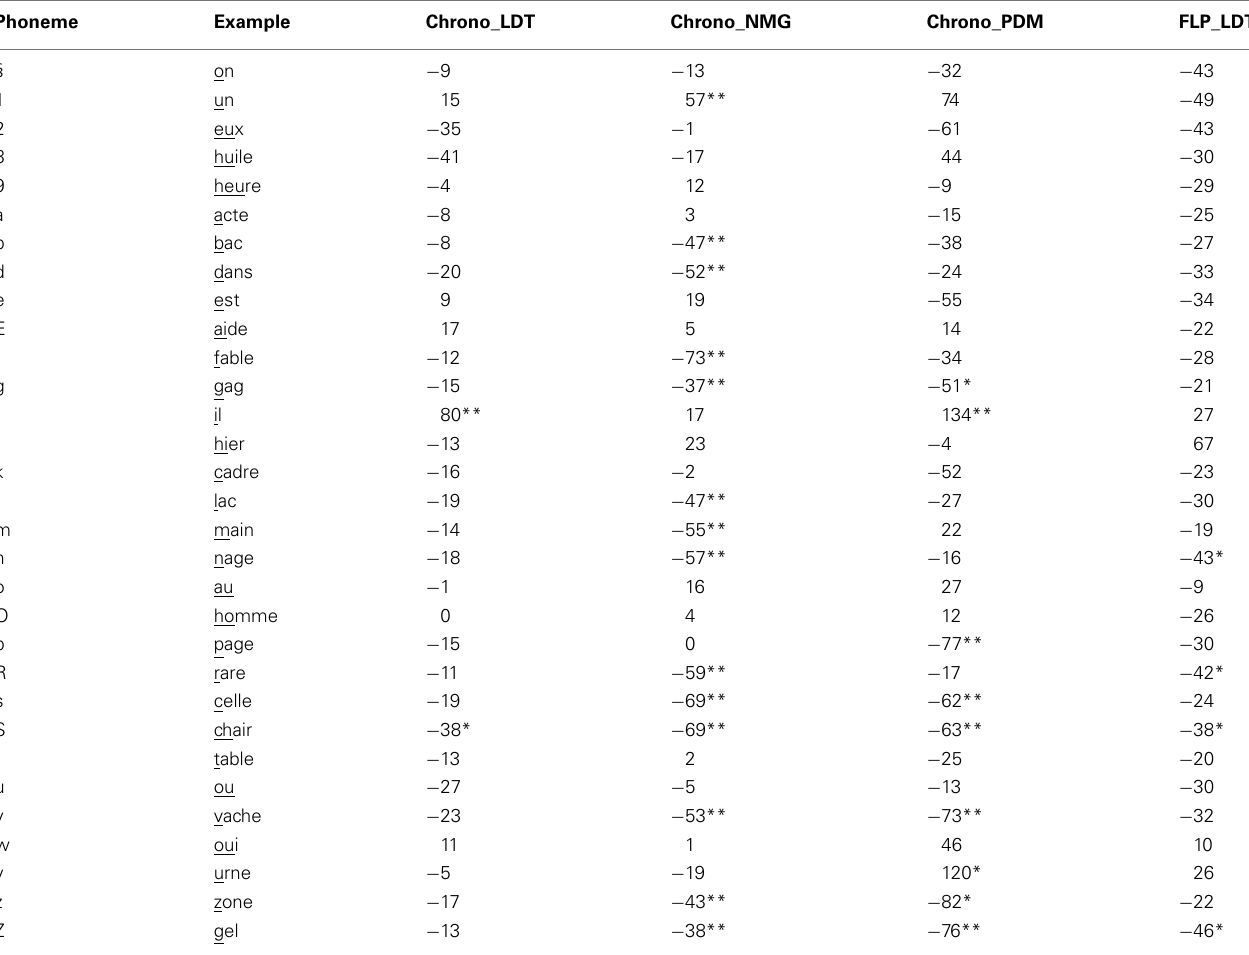
TableA1 | Estimates of the processing times induced by different French phonemes in the different tasks (relative to the phoneme @ as in